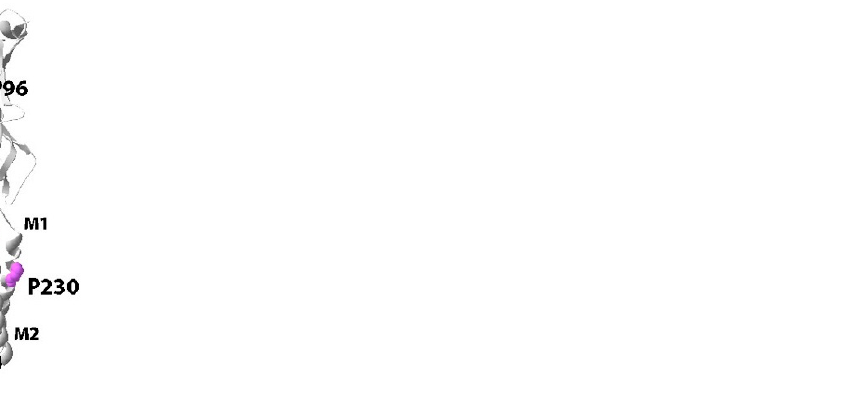
Figure 1. Cartoon of a GlyR  1 subunit showing the location of Pros examined in this study. P30 and P96 are in the ECD, P146 is at the ECD/TM interface, and P230 is on M1 in the TM